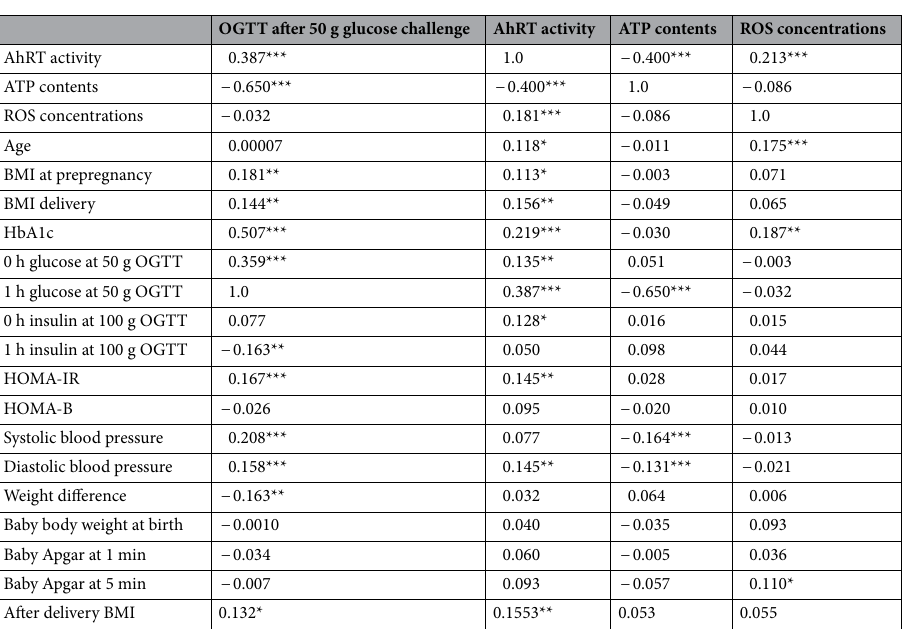
Table 2. Pearson correlations coefficients(r) between the aryl hydrocarbon receptor transactivating (AhRT) activity and metabolic parameters in the pregnant women with gestational diabetes. ROS reactive oxygen species, BMI body mass index, OGTT oral glucose tolerance test, HOMA-IR homeostatic model assessment for insulin resistance, HOMA-B HOMA for β-cell function, Apgar appearance, pulse, grimace, activity, and respiration. *Significantly correlated at P < 0.05, ** P < 0.01, and *** P <